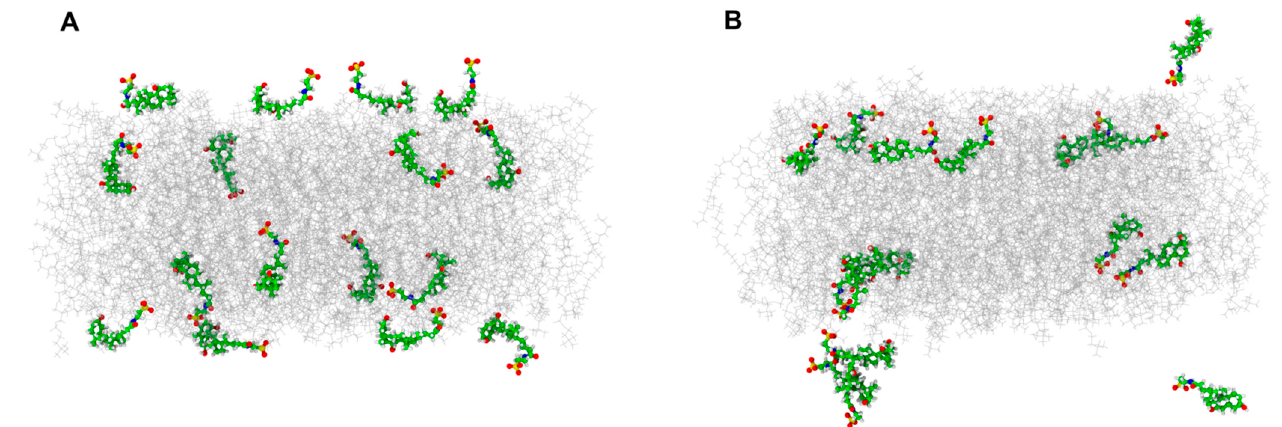
Figure 4. MD simulation of TUDCA in the POPC membrane. ( A )—start, 0 ns, ( B )—end, 500 ns. Colors of atoms: red—oxygen, yellow—sulphur, blue—nitrogen and green—carbon. Water molecules are removed for clarity. Animation showing TUDCA molecules movement is provided as supplementary material (Animation S1).